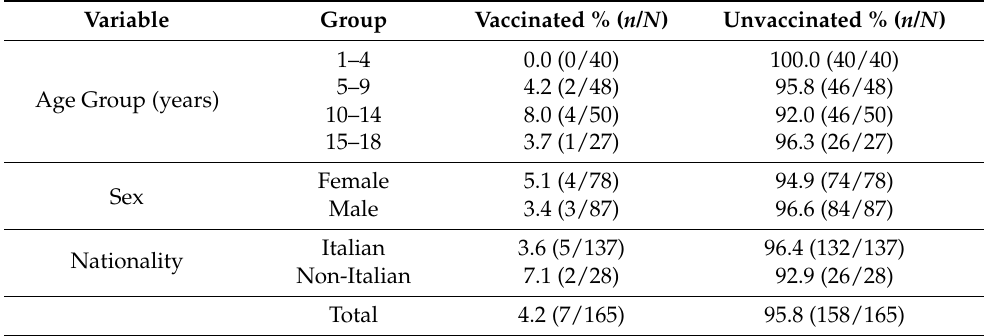
Table 4. Vaccination status stratified by age group, sex, and nationality ( n / N : number of subjects/total).